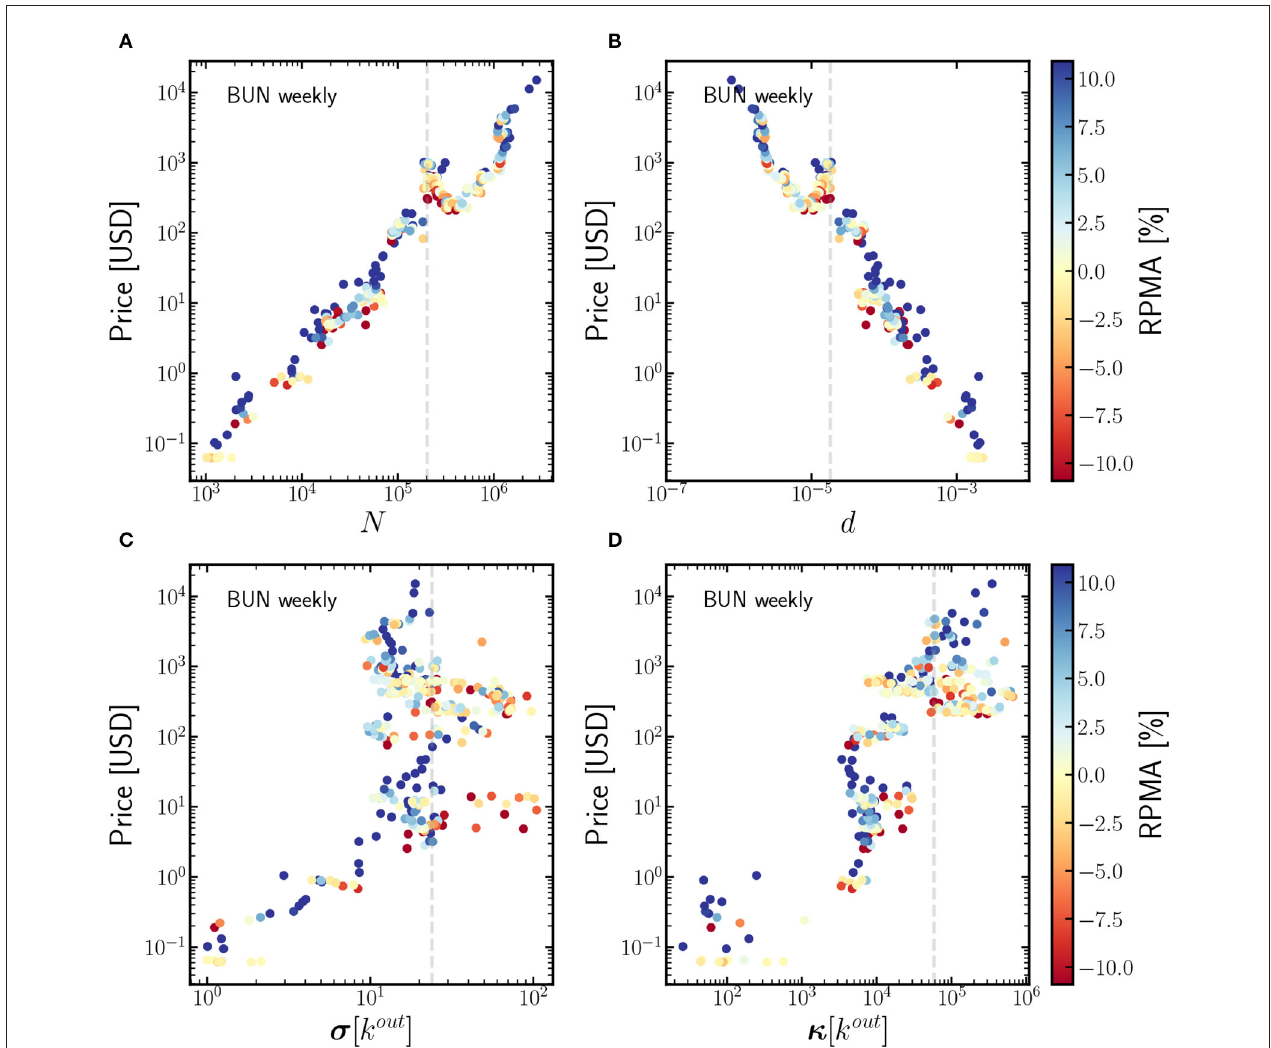
FIGURE 2 | Correlation between the Bitcoin price in USD, the basic statistics (number of nodes and link density - A,B ) and the moments of the out-degrees distribution (C,D) for the BUN at the weekly time scale. Additionally, each dot representing an observation is colored according to the value of the Ratio between the current Price and its Moving Average (RPMA) indicator. The vertical, dashed line coincides with the bankruptcy of Mt. Gox. Purely structural quantities are correlated with exogenous quantities as the Bitcoin price; see, for example, the evolution of the out-degrees standard deviation whose larger values (observable after the Mt. Gox failure) correspond to price drops. See also